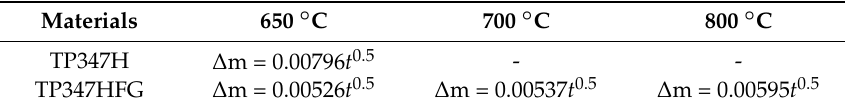
Figure 3. Weight gain curves ofTP347H and TP347HFG in a steam environment. ( a ) 650 ◦ C; ( b ) 700 ◦ C; ( c ) 800 ◦ C. Table 2. Oxidation constants of TP347H and TP347HFG.